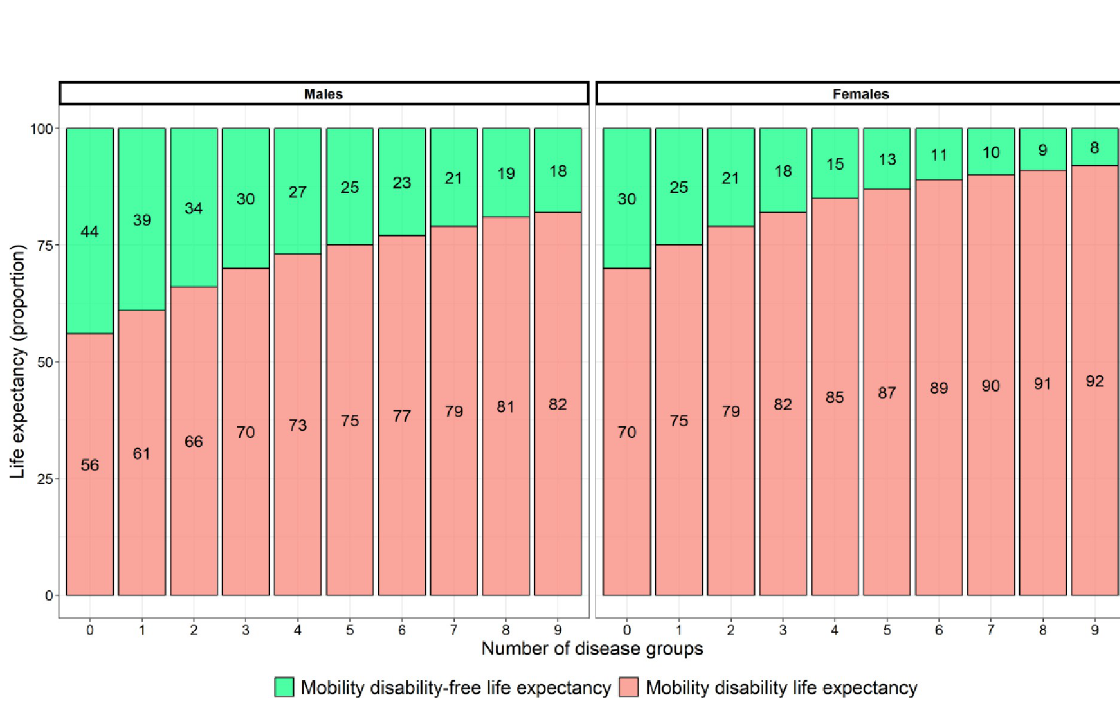
Fig 4. Remaining life expectancy (as a proportion) spent with and without mobility disability for each disease group count, in male and female participants at age 85.